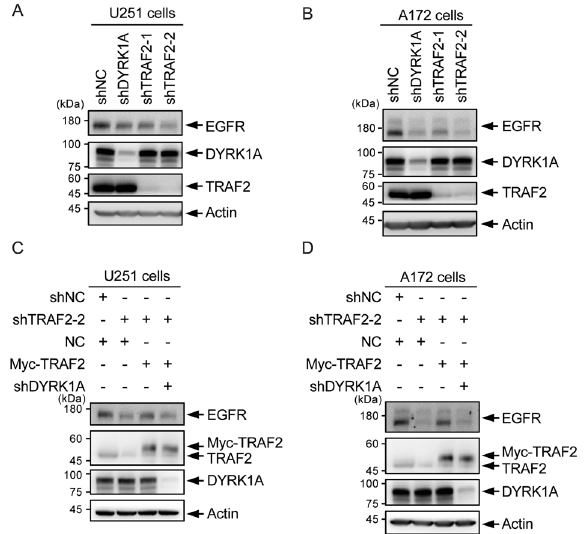
Fig. 6 TRAF2 regulates EGFR protein stability through DYRK1A. A TRAF2 knockdown affects EGFR protein level. DYRK1A and